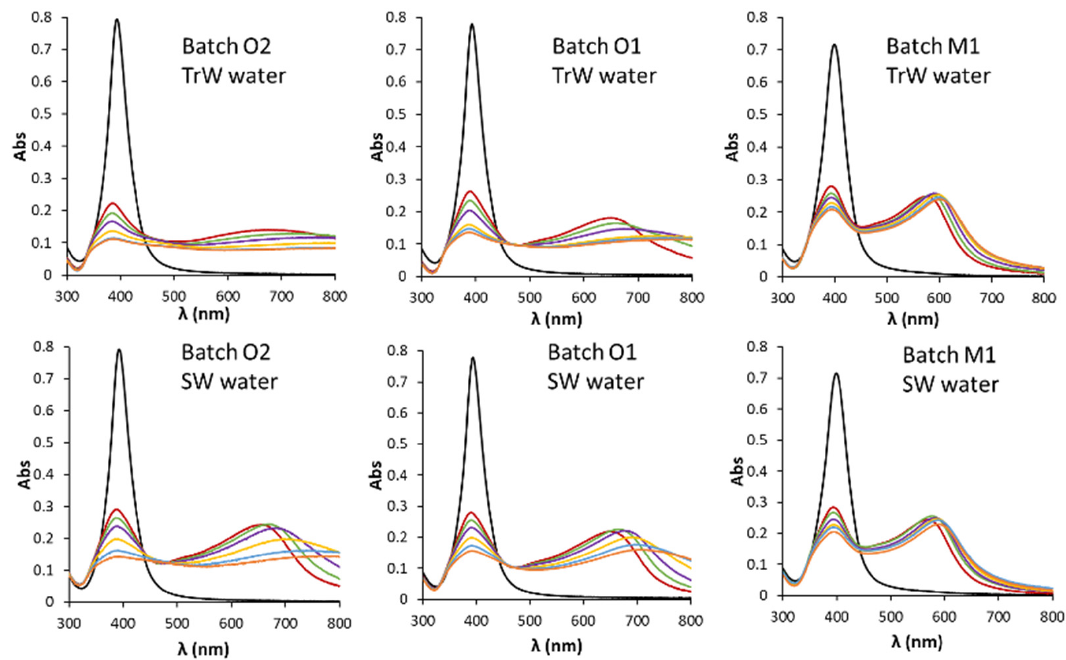
Figure 7. Spectra of the several batches diluted 1/4 with transitional and sea waters measured at several times (0.5, 1, 2, 5, 10, 15 min). The SPR band for the dilution with ultrapure water was also included.